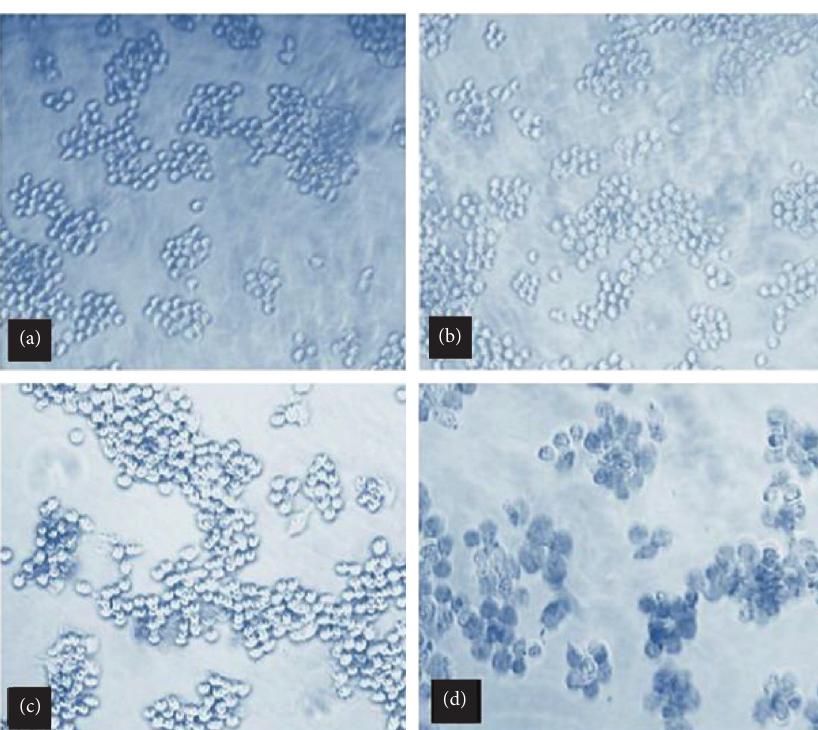
Figure 5: The effect of the ripen BG extracts (incubation with 5mg/mL extract) on the viability of the MDBK cancer cells. Most of the cancer cells remained healthy and viable when treated with 60% methanol extract (a), treating with 80% ripen BG fruit extract showed cells depletion effect but not prominently (b), treating with ripen BG extract in 100% methanol showed strong deformation of cell structure (c), and control methotrexate anticancer drug showed very strong cell death effect (d).